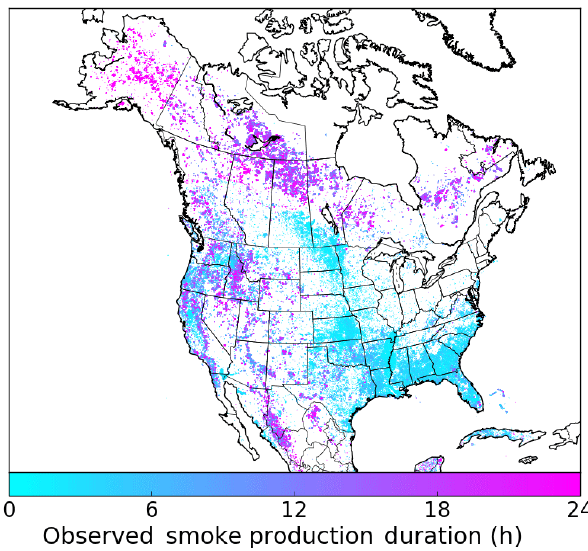
Figure 2. The locations of all HYSPLIT points analyzed between 2007 and 2014 shaded by the duration assigned by the analyst. HYSPLIT points are assigned a duration between 1 and 15, or